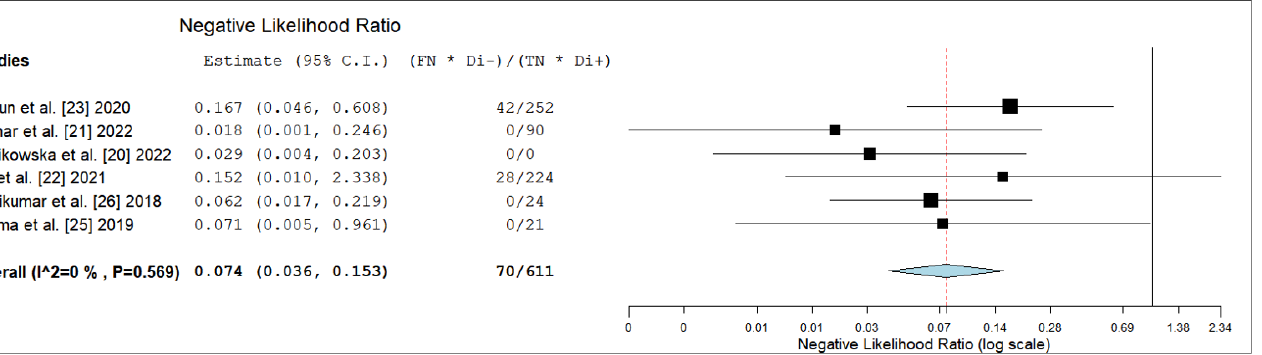
Figure 5. Negative likelihood ratio of the index test in high-grade glioma. Legend: 95% C.I. = 95% confidence interval; TP = true positive; TN = true negative; FP = false positive; FN = false negative. Diagnostic Odds Ratio